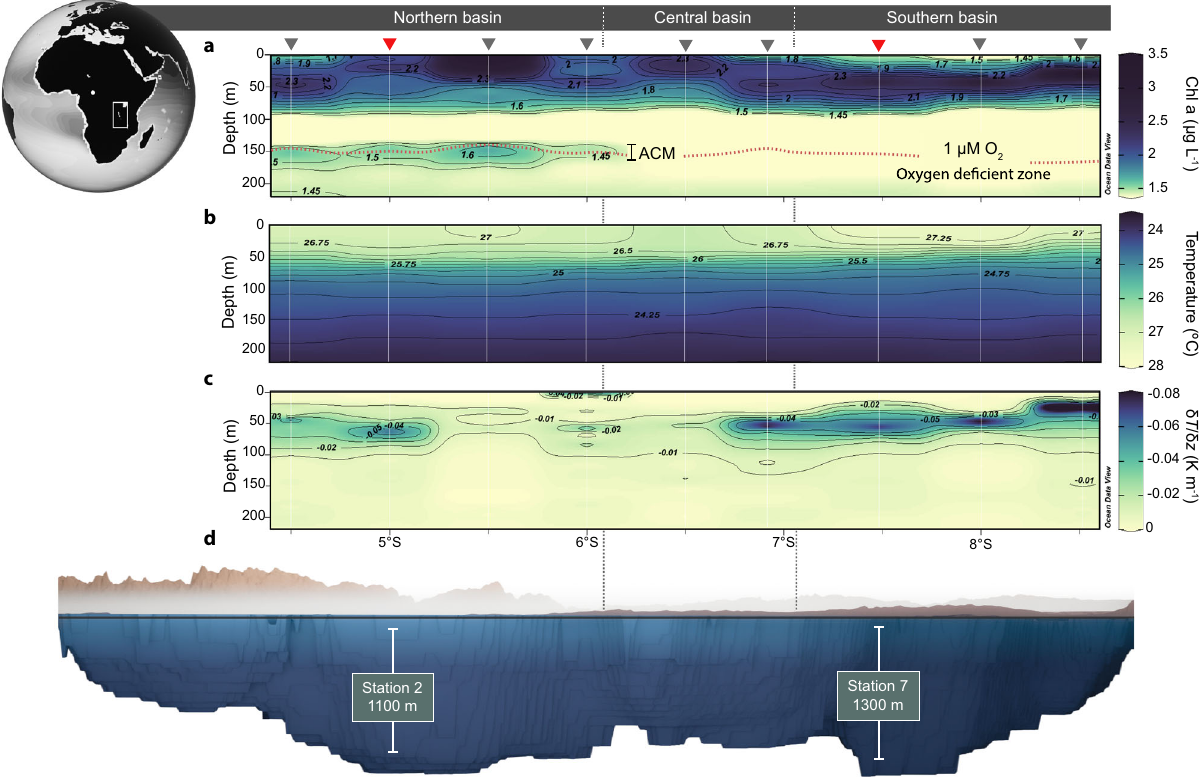
Fig. 1 Distribution of the anoxic chlorophyll maximum (ACM) in the oxygen-de fi cient zone of Lake Tanganyika. Data shown are from the April – May 2018 campaign, while a return expedition was made in April – May 2019 to better resolve the vertical structure and nitrogen transformation processes in the ACM, shown in Figs. 2 and 3. a In situ chlorophyll a fl uorescence. The oxygen-de fi cient zone is delimited at an O 2 cutoff of 1 μ M indicated by the dotted line. The main sampling stations 2 and 7 are marked by red triangles, while additional sampling stations are indicated by black triangles. b Temperature distribution. c Vertical temperature gradient. d Bathymetry of Lake Tanganyika and the sill that separates the North, Central, and South basins, based on the bathymetry map by Cohen et al. 57 . The lake water column is denoted in blue, while the surrounding mountain terrain is indicated in